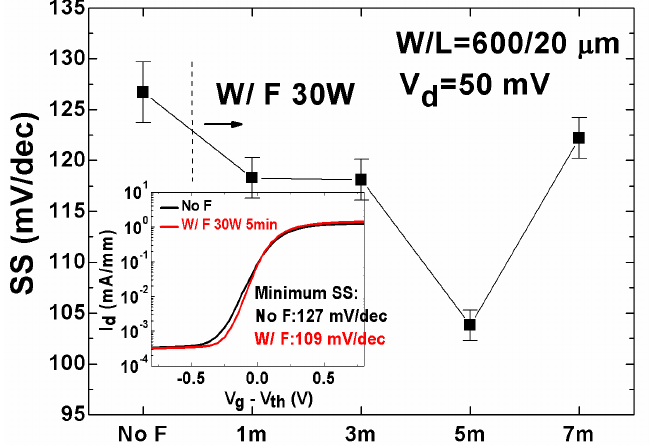
plasma treatment for 30 W/5 4